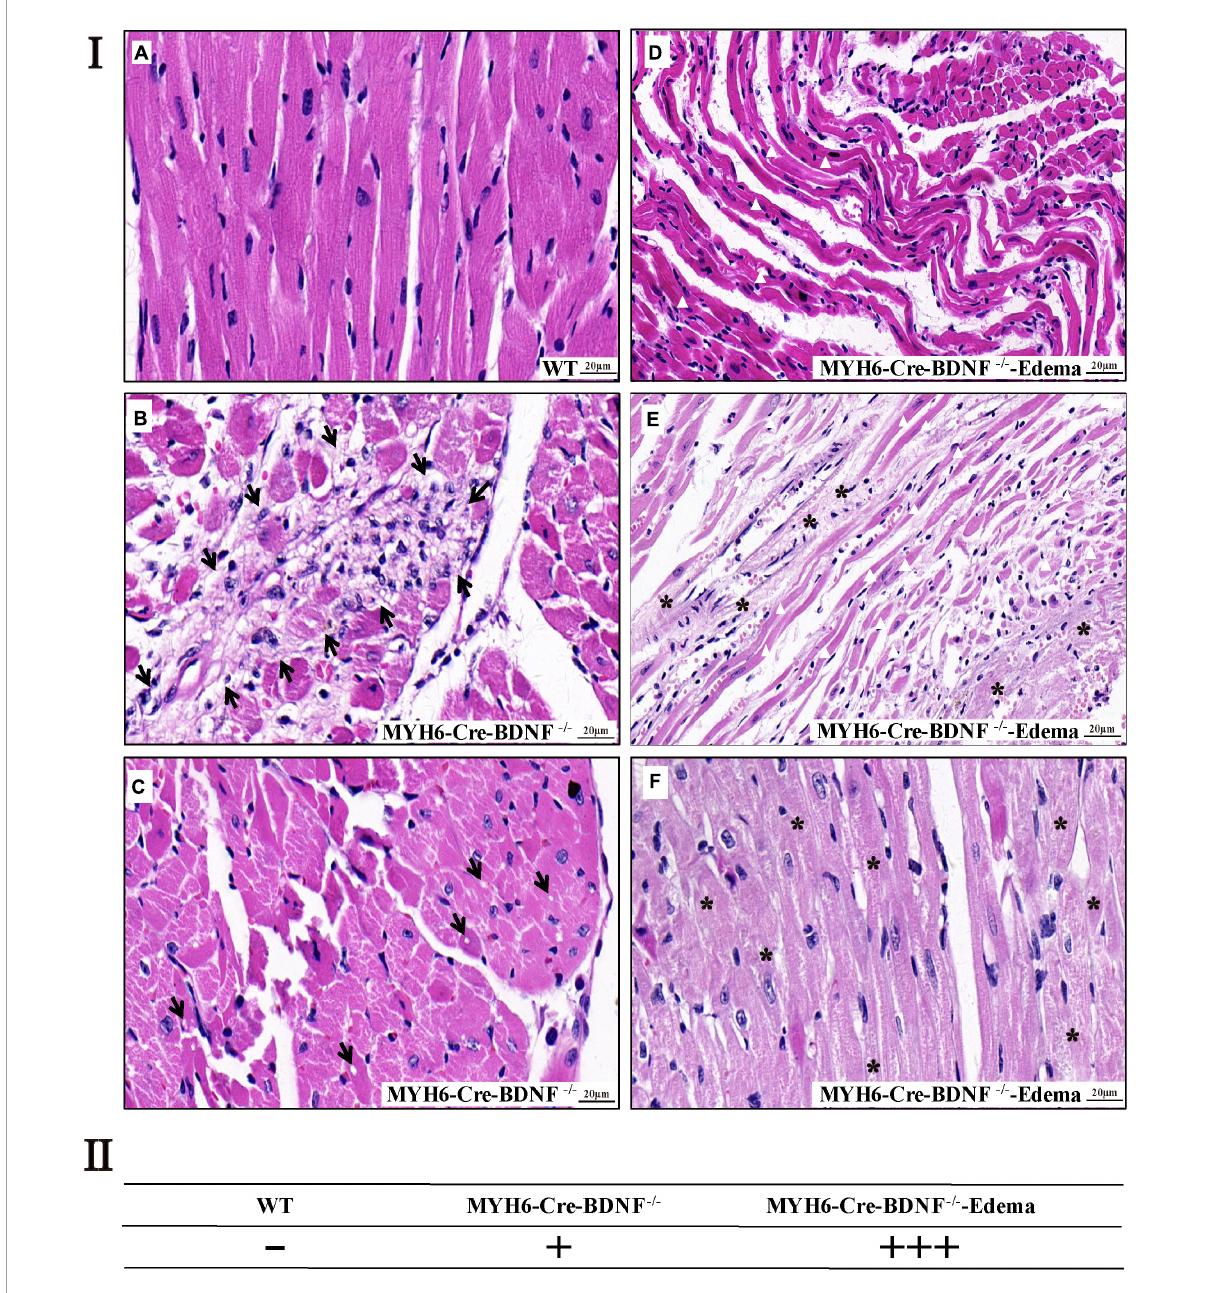
FIGURE4 Cardiomyocyte death and degenerative changes in the myocardium are found in young adult MYH6-Cre-BDNF − / − hearts (I) H&E histological staining revealed that in 3-month-old MYH6-Cre-BDNF − / − hearts but not in WT hearts (a) , focal cardiomyocyte death, focal degenerative changes in cardiomyocytes, focal inflammation in the myocardium ( b ; arrow) and focal loss of nuclei in cardiomyocytes ( c ; arrow) were found, while in 3-month-old osmotic edema MYH6-Cre-BDNF − / − hearts, in addition to the above pathological changes, severe muscle fiber atrophy and disorder ( d,e ; white triangle), unclear transverse striation of myocardial fibers ( e,f ; asterisk) and interstitial loosening (d,e) were also found in the myocardium. n = 5 and 4 for the 3-month-old male WT and MYH6-Cre-BDNF − / − groups respectively; n = 3 for the 3-month-old male MYH6-Cre-BDNF − / − edema group. (II) Semi-quatitation of I. n = 3. Bar size as shown in the